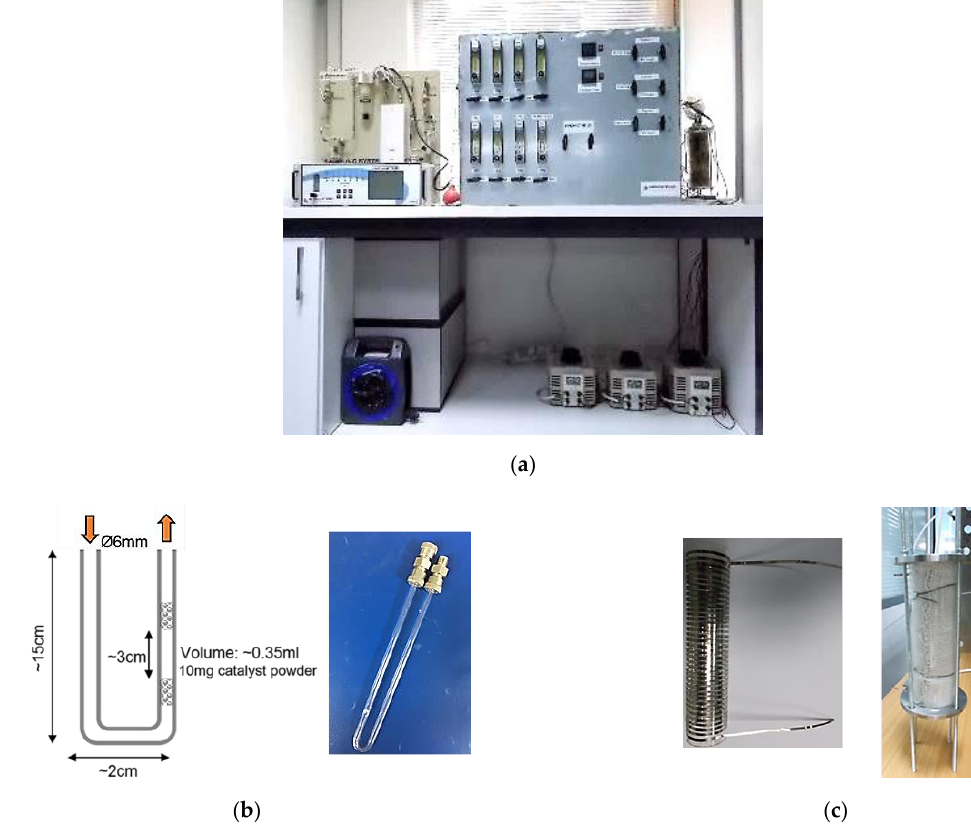
Figure 6. ( a ) Synthetic gas bench (SGB); ( b ) U-shaped quartz reactor for activity testing of catalyst powders; ( c ) tube experimental electrical furnace. Table 2. Selected gas mixtures concentrations for λ ≈ 0.99 and λ ≈ 1.03. Gas